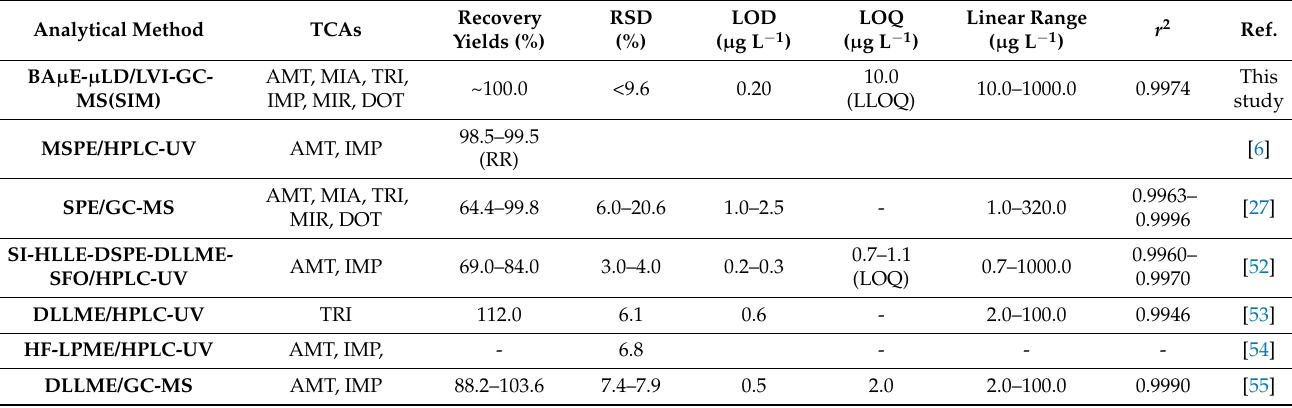
Table 5. Comparison between the present study and others analytical approaches already reported in the literature for each six TCAs determination in urine and water matrices.